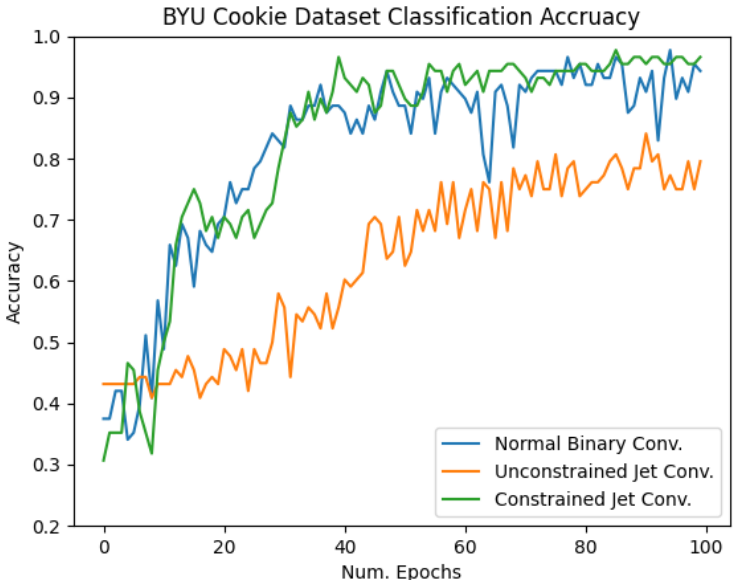
Figure 11. Classification accuracy on the BYU Cookie dataset.